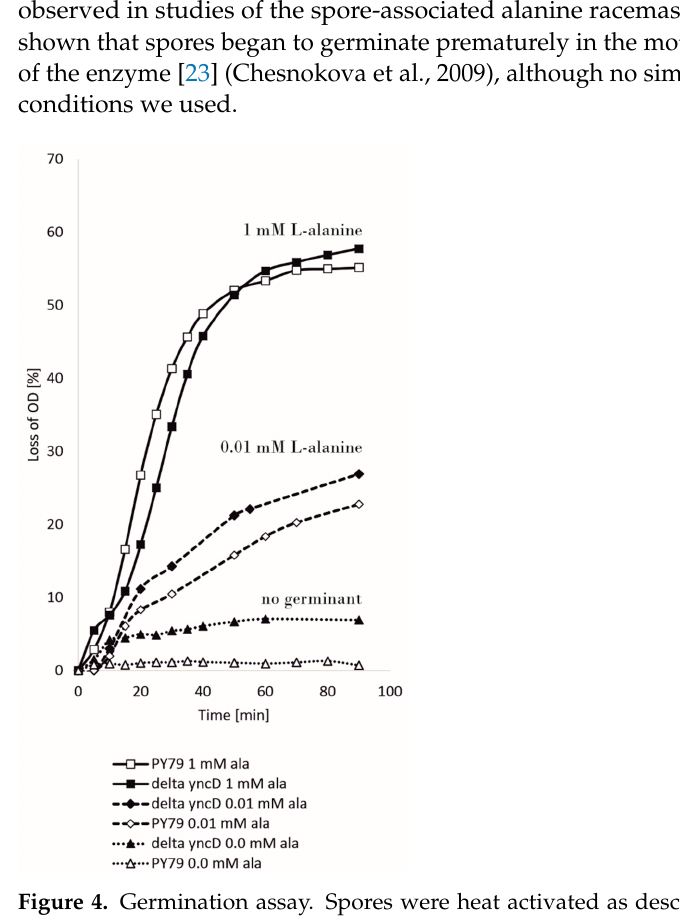
Figure 4. Germination assay. Spores were heat activated as described in Material and Methods, induced to germinate by L -alanine in PBS buffer and the OD 600 was monitored. The assays were repeated at least four times using independent spore